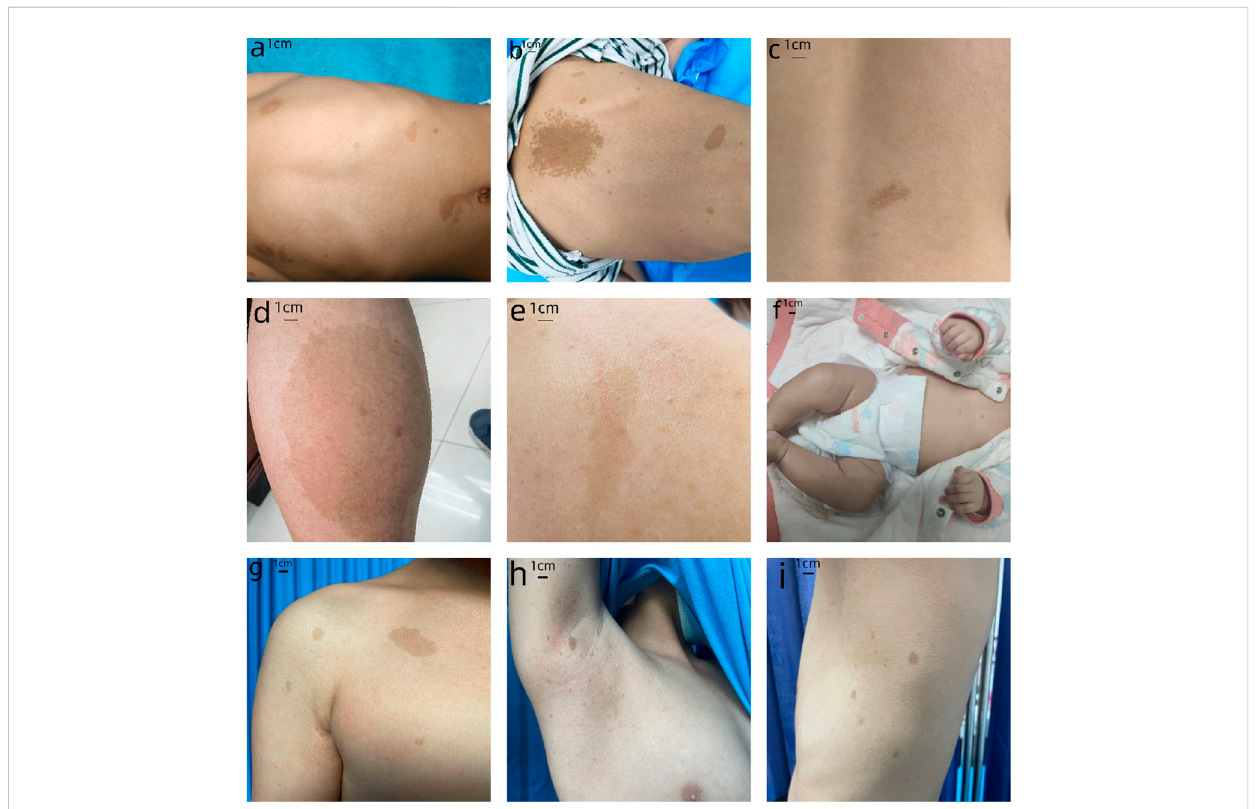
FIGURE 2 Clinical photographs. (A) The fi rst proband: sporadic CALMs were observed in the patient ’ s abdomen and back since she was born, which spread slowly to the anterior chest and face. (B) The second proband: CALMs were observed in the back and hip of the patient since he was born and then gradually spread to the face and neck. (C) The brother of the second proband: a pigmented spot with a size of 2 cm was observed on his back. (D) The father of the second proband: a pigmented spot with a size of 10 cm was observed on his left calf. (E) The mother of the second proband: several scattered pigmentated spots were observed on the back (F) The third proband: CALMs were observed on the patient ’ s chest. (G) The fourth proband: CALMs were observed on the patient ’ s armpit and back. (H) The fi fth proband: CALMs were observed on the patient ’ s thorax, back, and legs. (I) The sixth proband: CALMs were observed on the patient ’ s armpit and back.